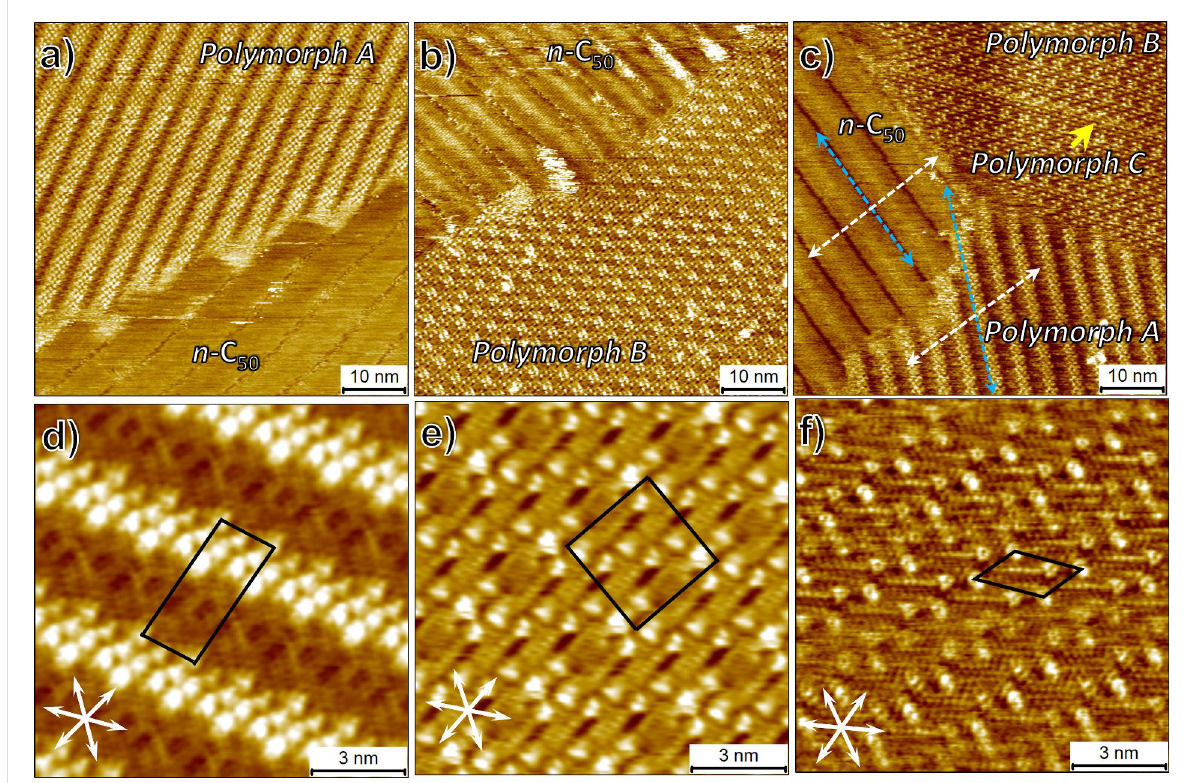
Figure 4: Self-assembled monolayers of BA-OC 14 formed on top of the n -C 50 buffer layer at the 1-phenyloctane–HOPG interface. The experiment was carried out using sequential deposition of the two solutions [ BA-OC 14 ] = 3.8 × 10 − 4 M, [ n -C 50 ] = 1.0 × 10 − 5 M. (a–c) Representative large scale STM images showing the formation of polymorph A and polymorph B atop the n -C 50 buffer layer. (d–f) Representative high-resolution images showing the structure of the polymorph A and polymorph B atop the n -C 50 buffer layer. The white double-headed arrows at the lower left corner of the image represent the three symmetry axes of the graphite lattice. Imaging conditions: (a) I set = 120 pA, V bias = − 1.2 V; (b) I set = 110 pA, V bias = − 1.45 V; (c) I set = 140 pA, V bias = − 0.45 V; (d) I set = 20 pA, V bias = − 0.17 V; (e) I set = 110 pA, V bias = − 1.45 V; (f) I set = 190 pA, V bias = − 0.4 V. For additional large-scale images, see Figure S4 in Supporting Information File